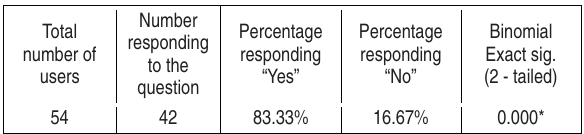
Table 1. Extent to which users read